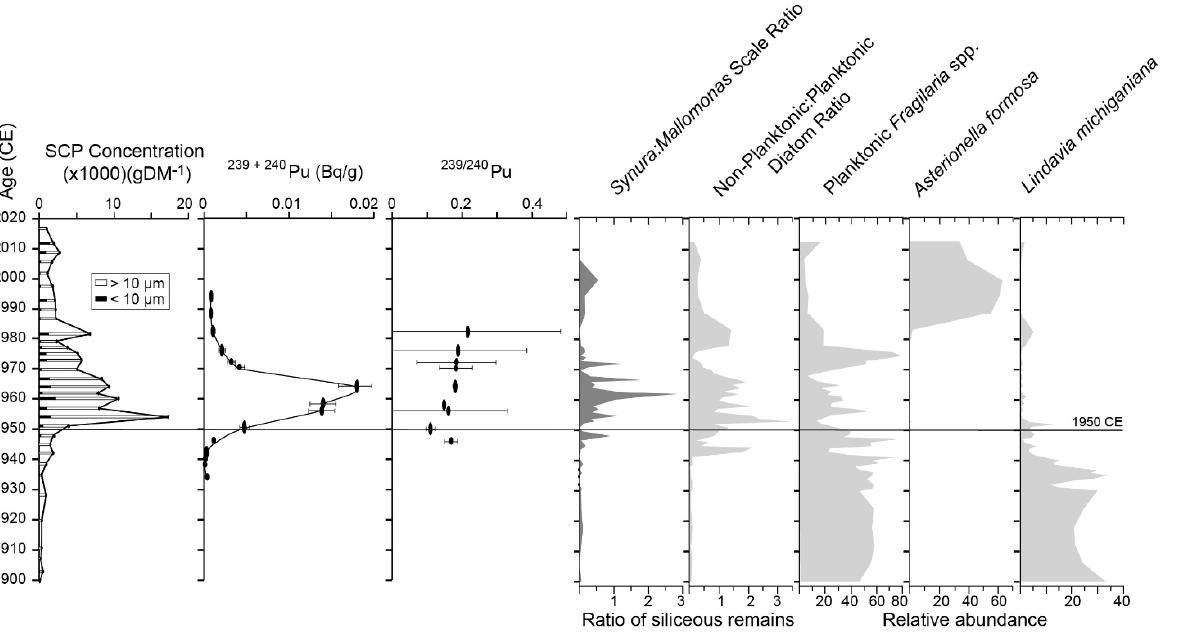
Figure 8. Summary of key Anthropocene markers and associated ecosystem response to increased fossil fuel combustion and industrial emissions in Crawford Lake recorded by siliceous microfossils in samples from freeze cores CRA19-2FT-B2 and CRA19-2FT-D1 collected along varve boundaries using the age model described herein. The total plutonium ( 239+240 Pu) closely mirrors the global fallout of radionuclides calculated based on the yields of individual nuclear tests (United Nations Scientific Committee on the Effects of Atomic Radiation / UNSCEAR, 2000), peaking in 1963 CE but slowing during the moratorium between November 1958 and February 1961, and the plutonium ratios are suggestive of thermonuclear weapons of the Cold War. Reprinted with permission from [30] McCarthy et al. 2023/ in press .